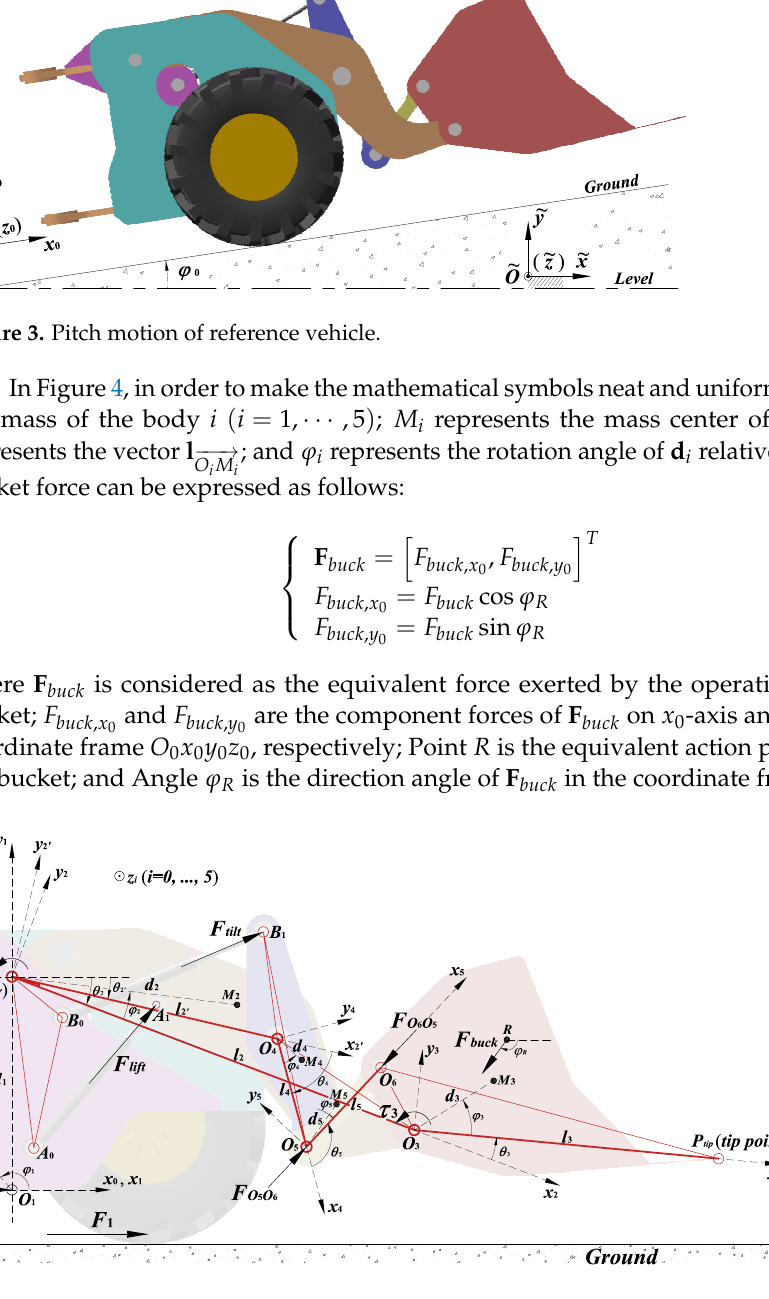
Figure 4. Dynamic model of the working mechanism